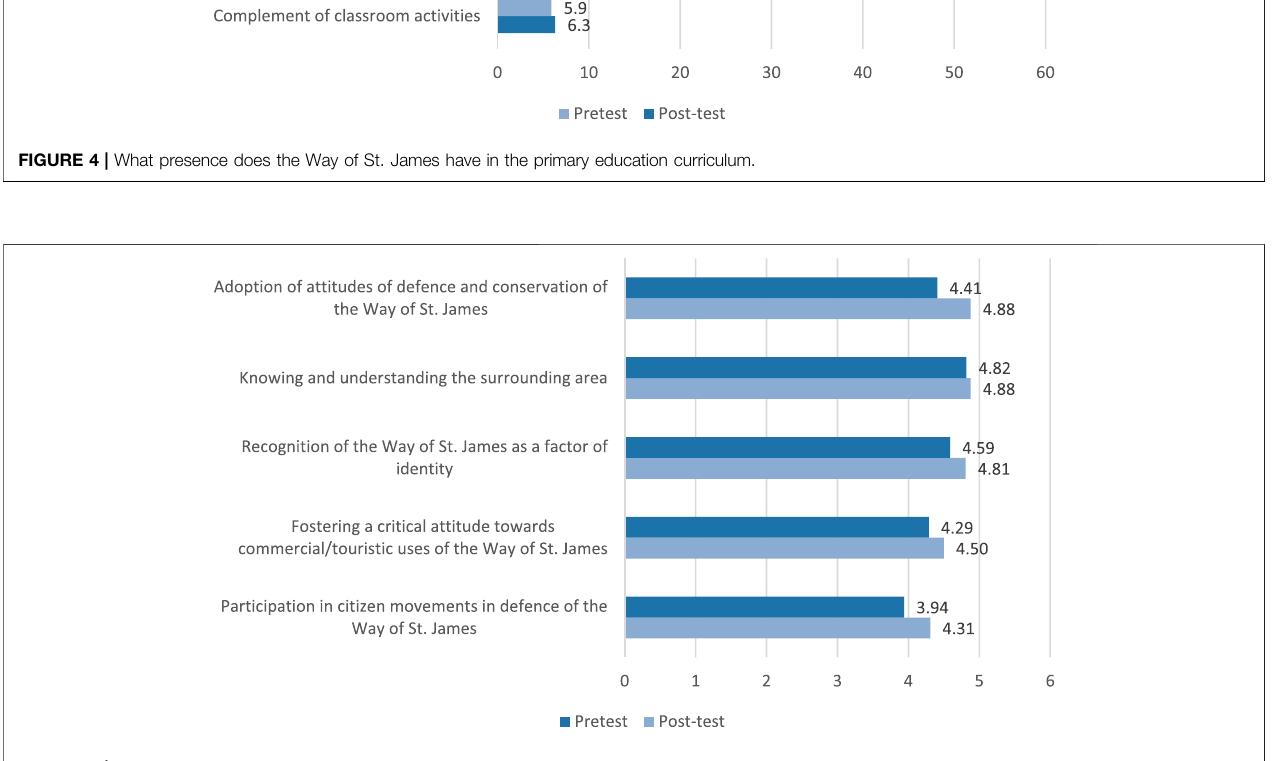
FIGURE 5 | Educational potential of the Way of St. James in primary